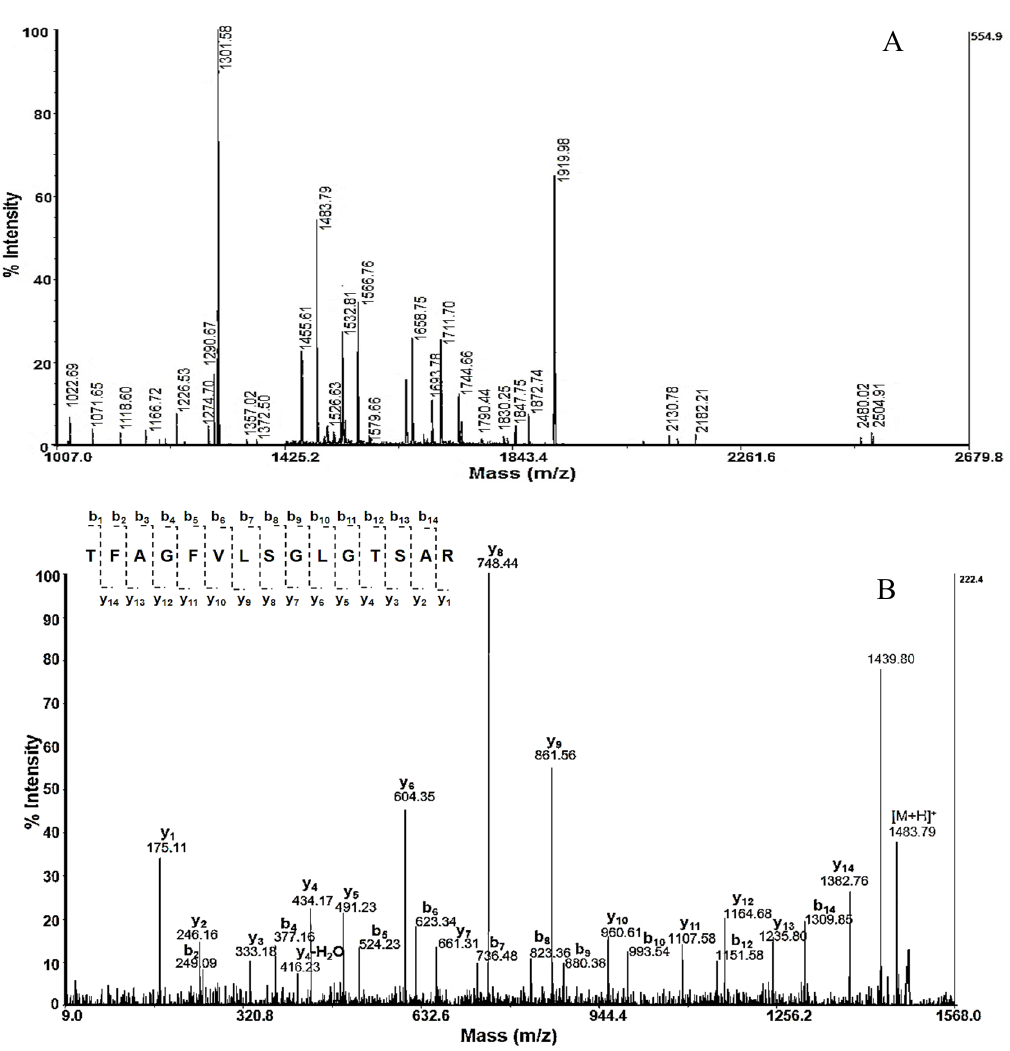
Figure 3. ( A ) MS spectrum of protein on band 2, the fraction with Mw 50–100 kDa of R. venosa hemolymph (Figure 1); ( B ) MS/MS spectrum and de novo sequence analysis of peptide at m / z 1483.79 [M+H] + .